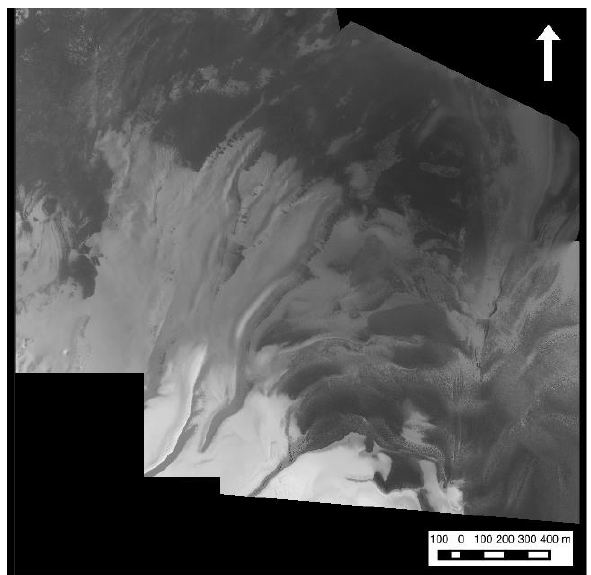
Figure 8 Differences displayed as a grey-level between orbit 2162 and 4162 (normalised, only showing overlapping